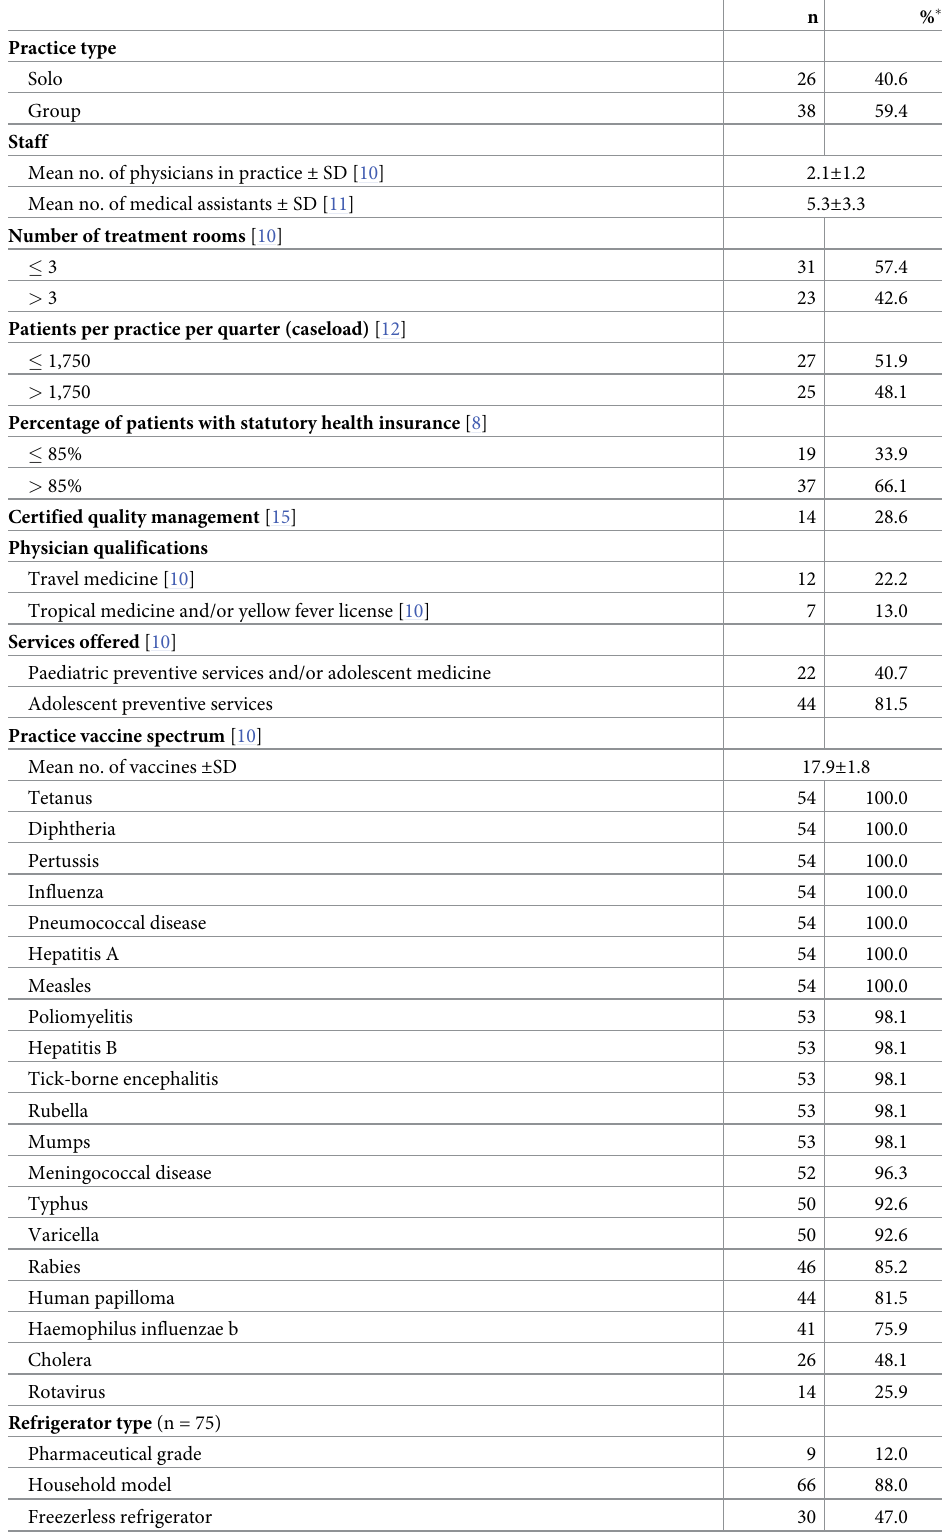
Table 1. Characteristics of participating practices (N =